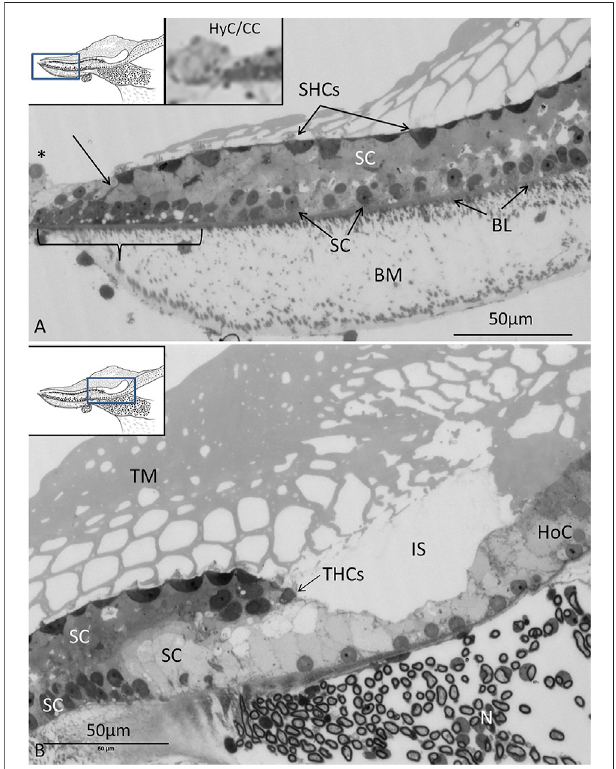
FIGURE 2 | (A) . Light microscopy of the papilla basilaris in C. rhombifer (highfrequencyregion).Theshorthaircells(SHCs)andtallhaircells(THCs)are darklystainedwithhairtuftsreachingintotheTM.Theauditoryorgancontains a large population of SCs whose cell nuclei are located basally. The honeycombed TM extends from the HoCs over the inner sulcus (IS). A homogenous population of mostly myelinated nerves (N) enters a fl uid- fi lled space before they reach the habenular openings where they lose the myelin layer. A blood vessel contains nucleated erythrocytes. (B) . TEM of the framed area shown in (A) . Fixation in 2.5% glutaraldehyde and 1% PFA in 2.5% phosphate buffer. Post- fi xation in 1% osmium tetroxide. Toluidine blue staining. BM: basilar membrane, uMNF: unmyelinated nerve fi bers, HyC: hyaline cells, cubic cells.